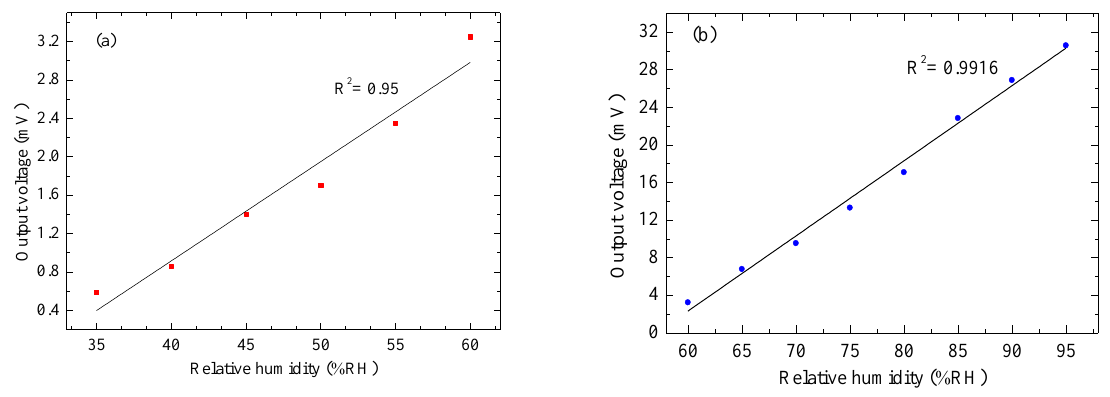
Figure 8. Output voltage of the CMOS-MEMS humidity sensor vs. changes in relative humidity level from ( a ) 35% RH to 60% RH; ( b ) 60% RH to 95% RH.